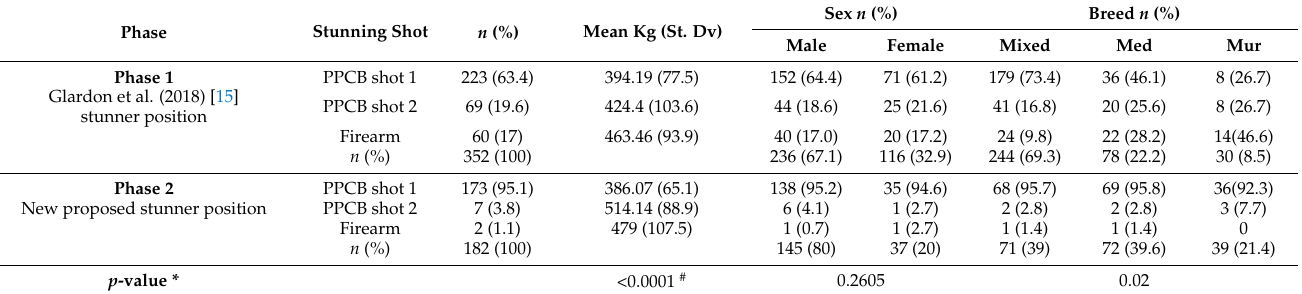
Table 1. Validation of anatomical site for an effective stunning procedure using a Pneumatic Penetrat- ing Captive Bolt (PPCB) according to breed, sex, and weight in 534